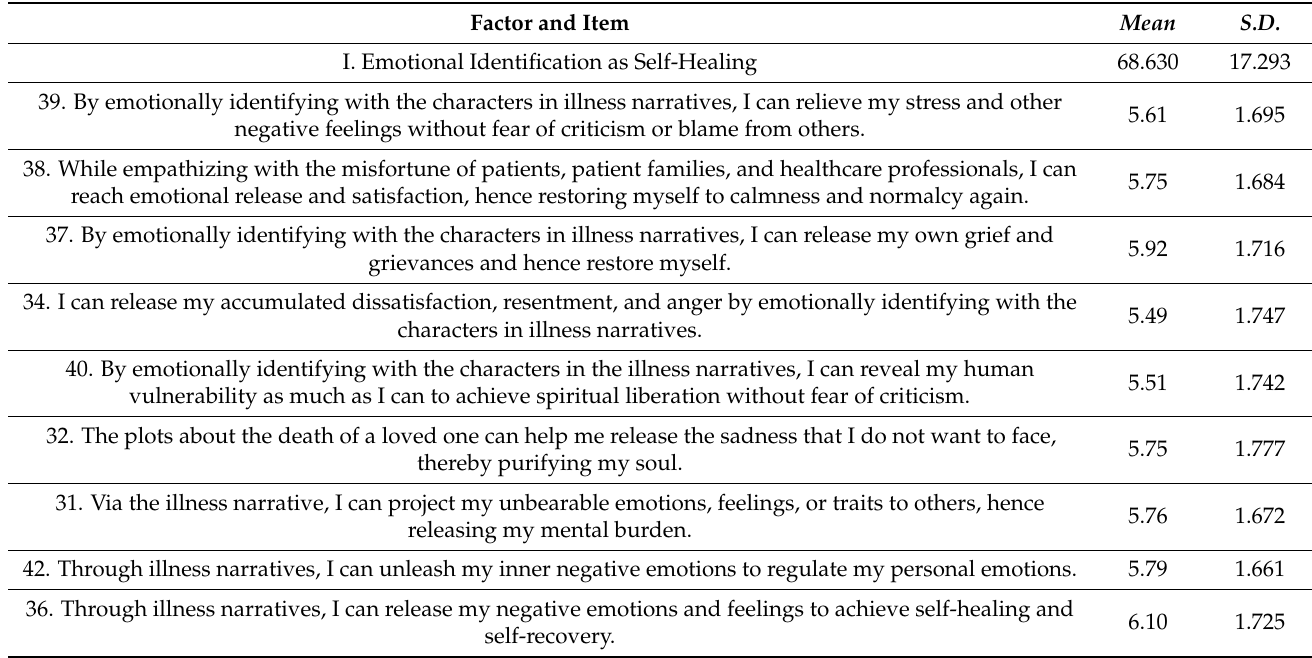
Table 2. Average item scores ( Mean ) and standard deviations ( S.D. ) on the ECS-IN. Factor and